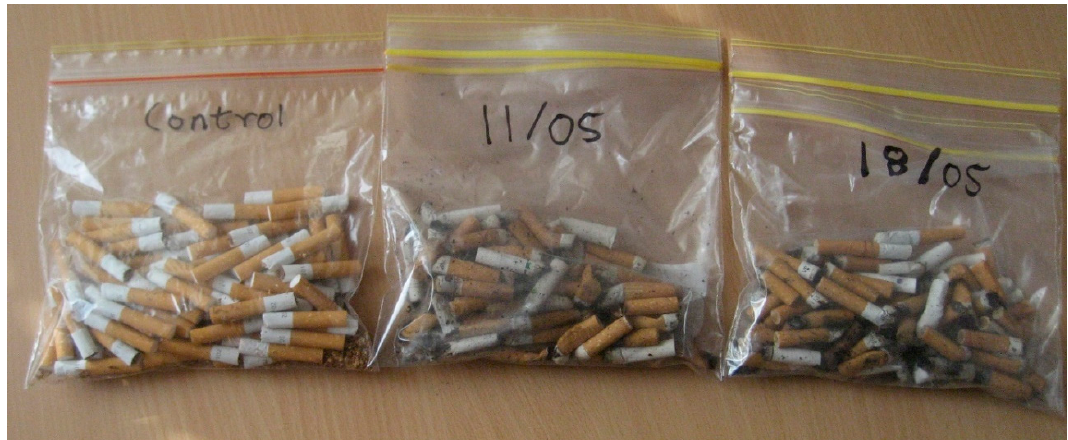
Figure 8. CB samples utilised for preliminary bacteriological study 1. The dates indicate when the used samples were collected in 2017.